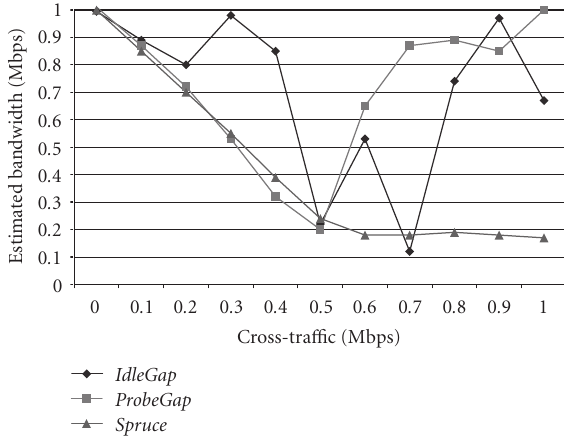
Figure 5: Estimated bandwidth with cross-tra ffi c.